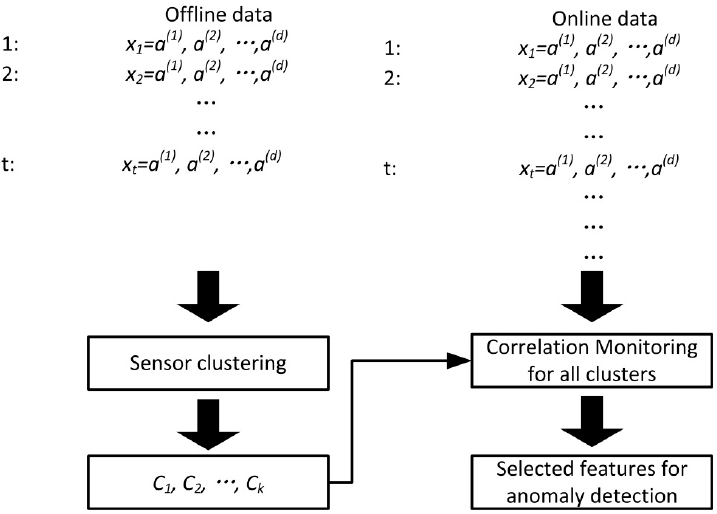
Figure 2. Workflow of our